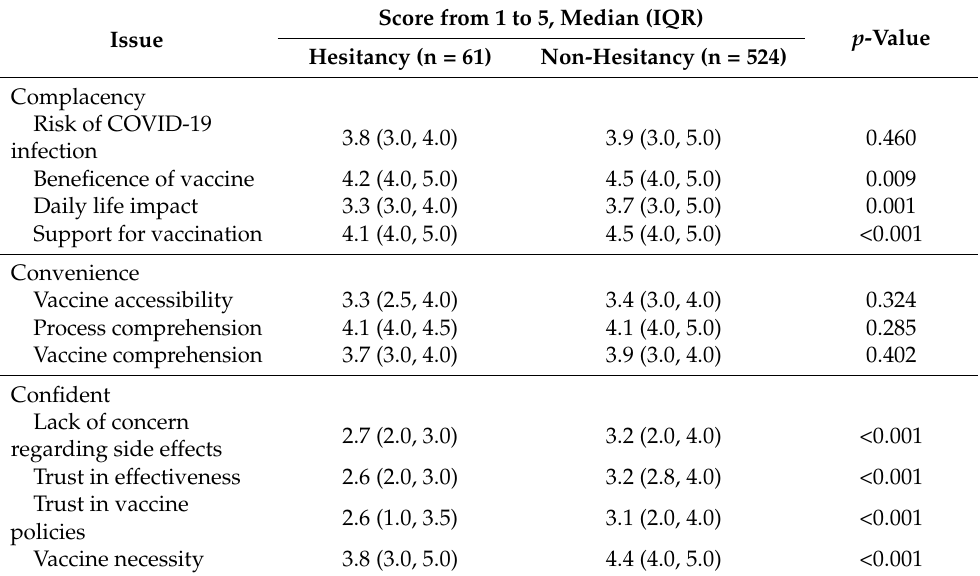
Table 4. COVID-19 vaccine hesitancy (n =